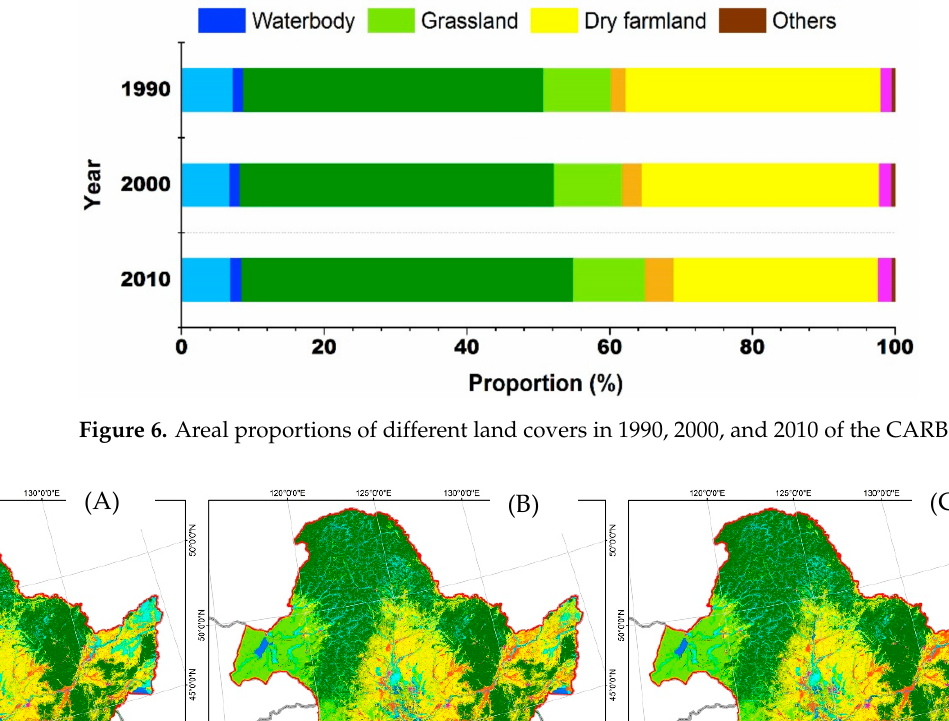
Table 5. Areal extents and changes of wetland and other land covers on the CARB.